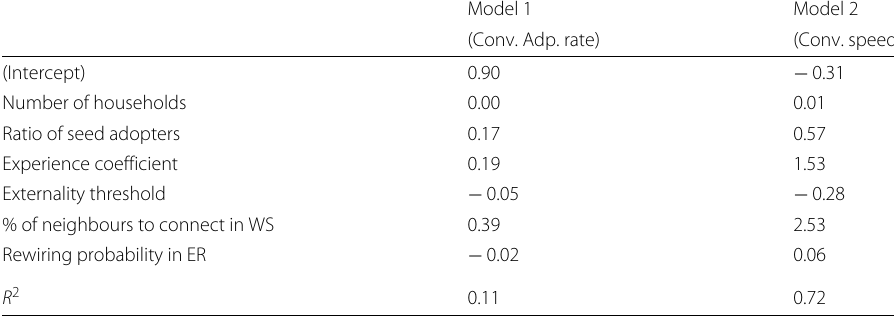
Table 2 Regressions of convergence adoption rate and convergence speed (negative externality effect)